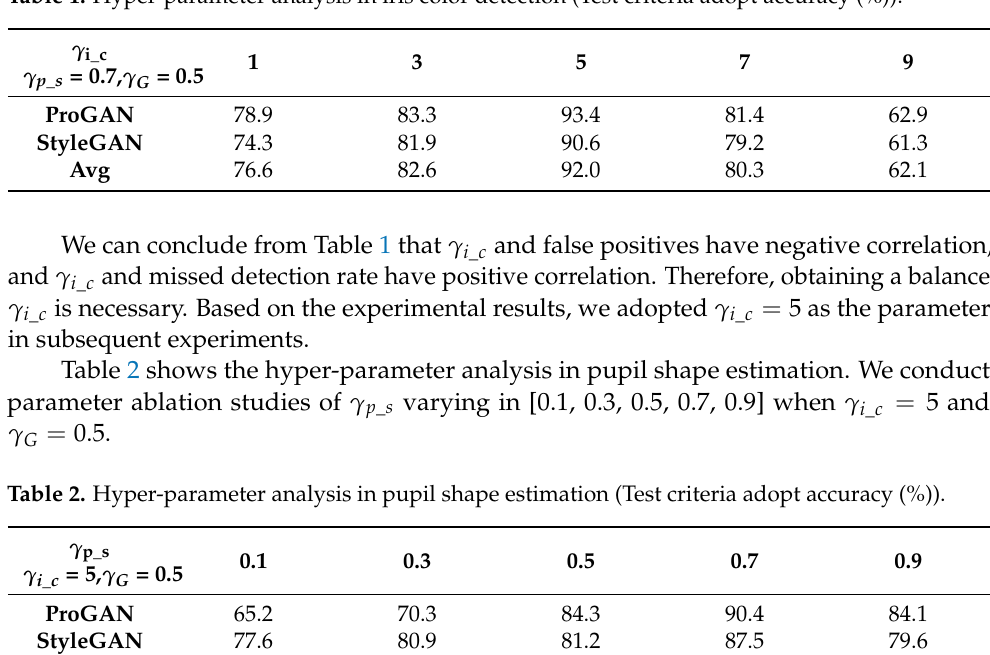
Table 1. Hyper-parameter analysis in iris color detection (Test criteria adopt accuracy (%)).